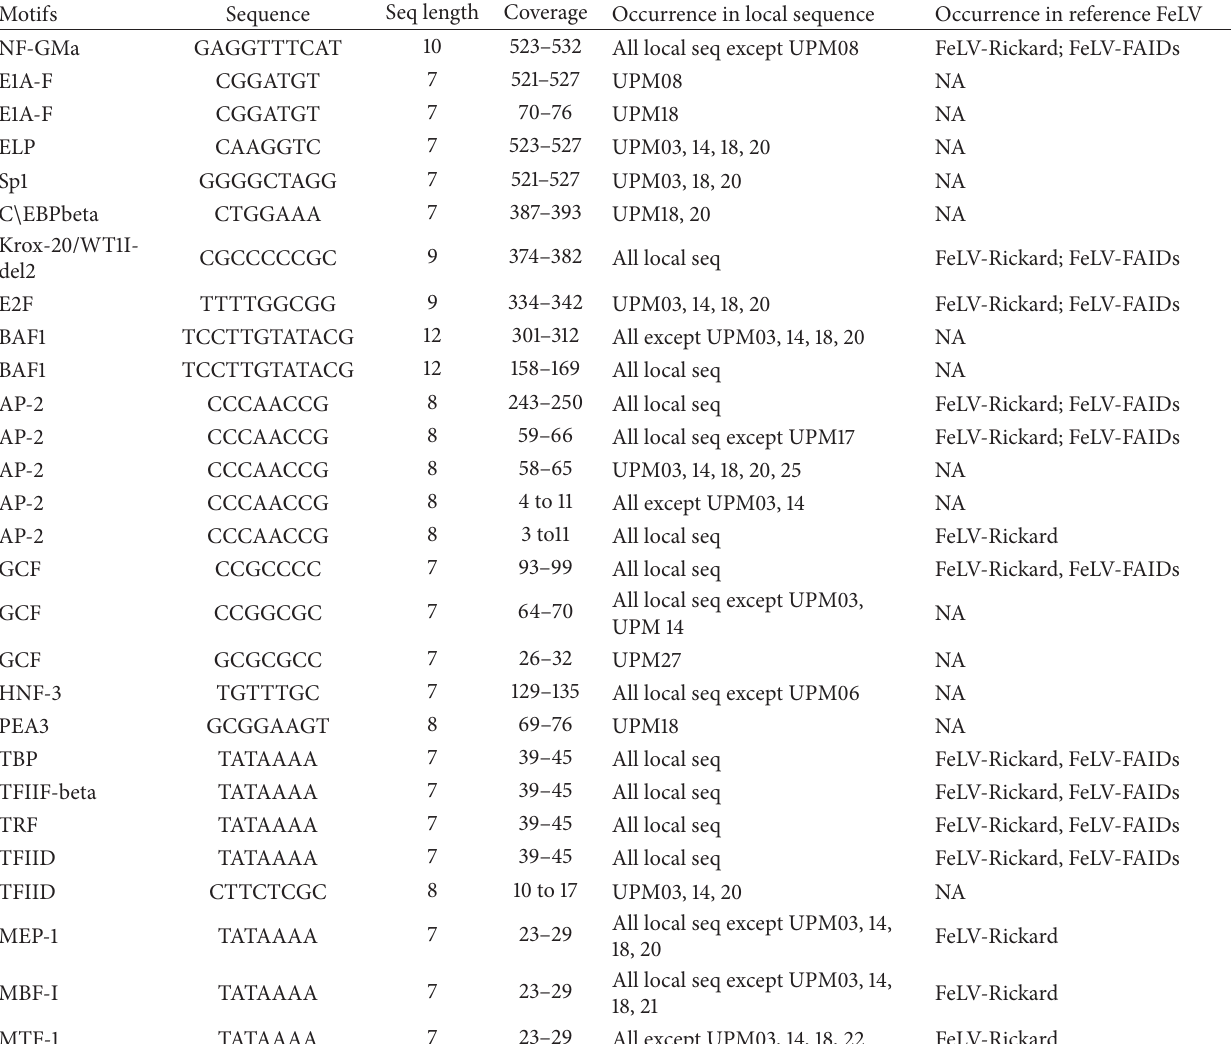
Table 2: Predicted transcription binding motifs found within the LTR-gag sequence of Malaysian FeLV